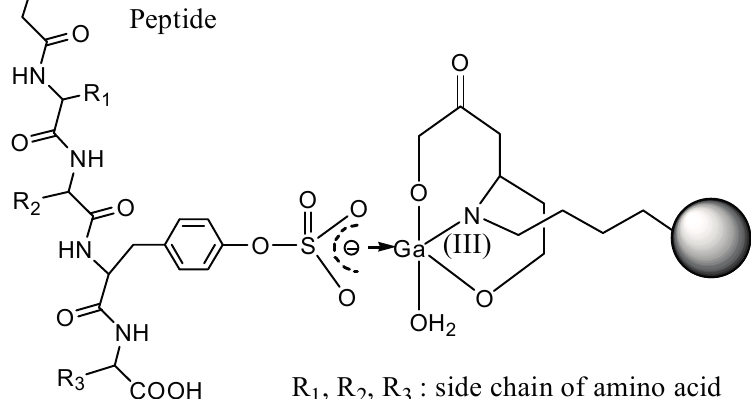
R , R , R : side chain of amino 1 2 3